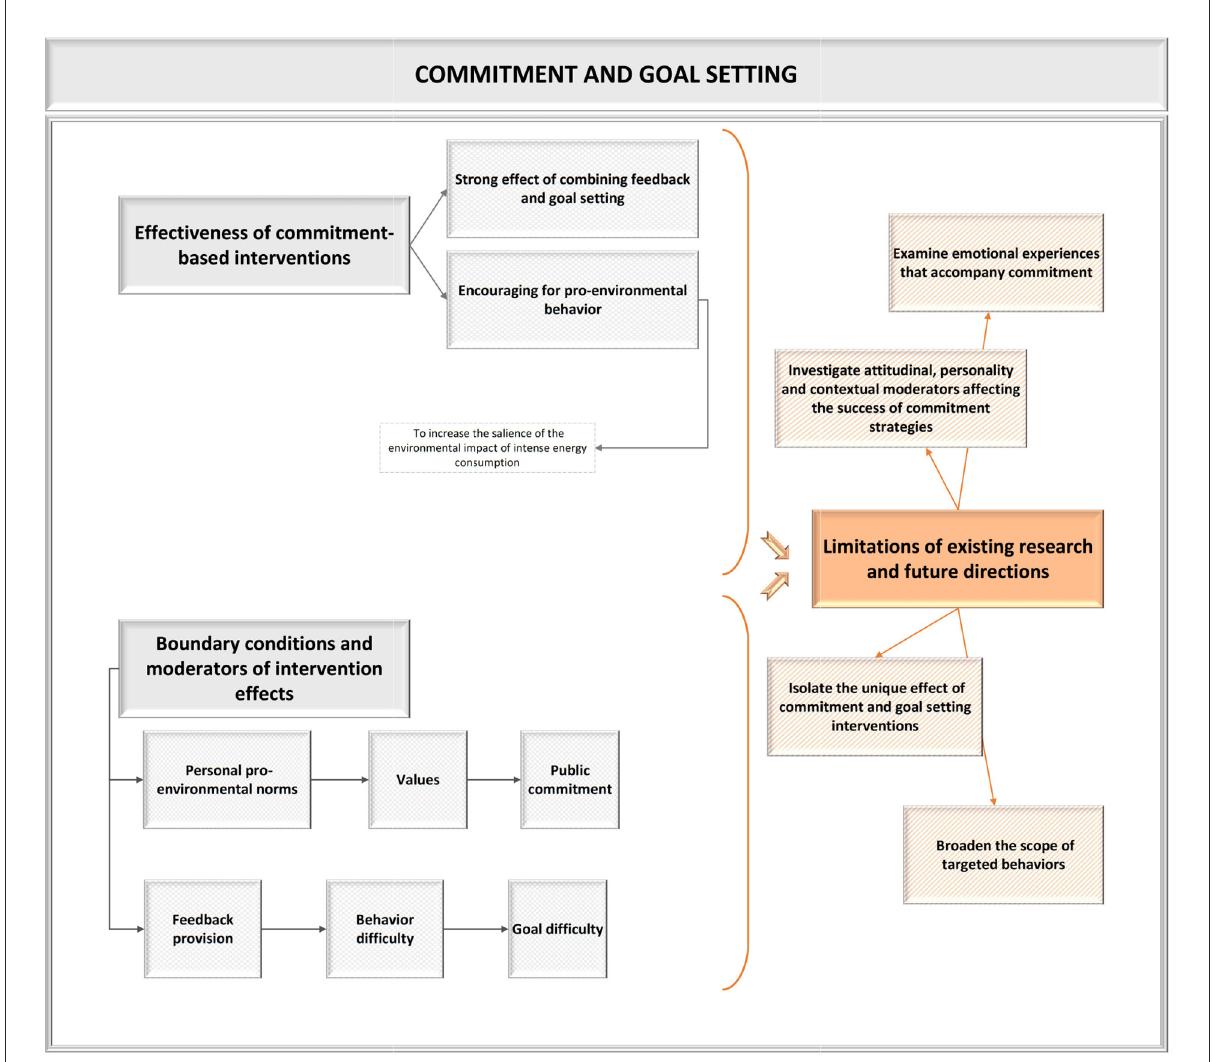
FIGUREA3 Overview of findings on